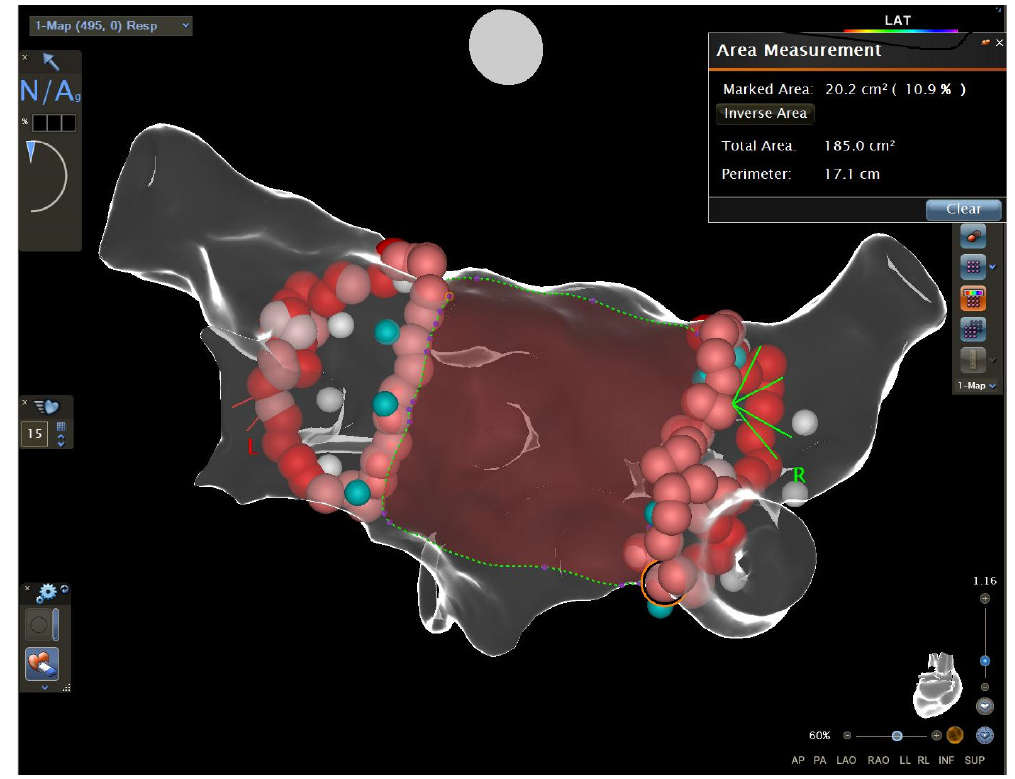
Figure 3. The measurement of the area between the encircling lines on the posterior wall.